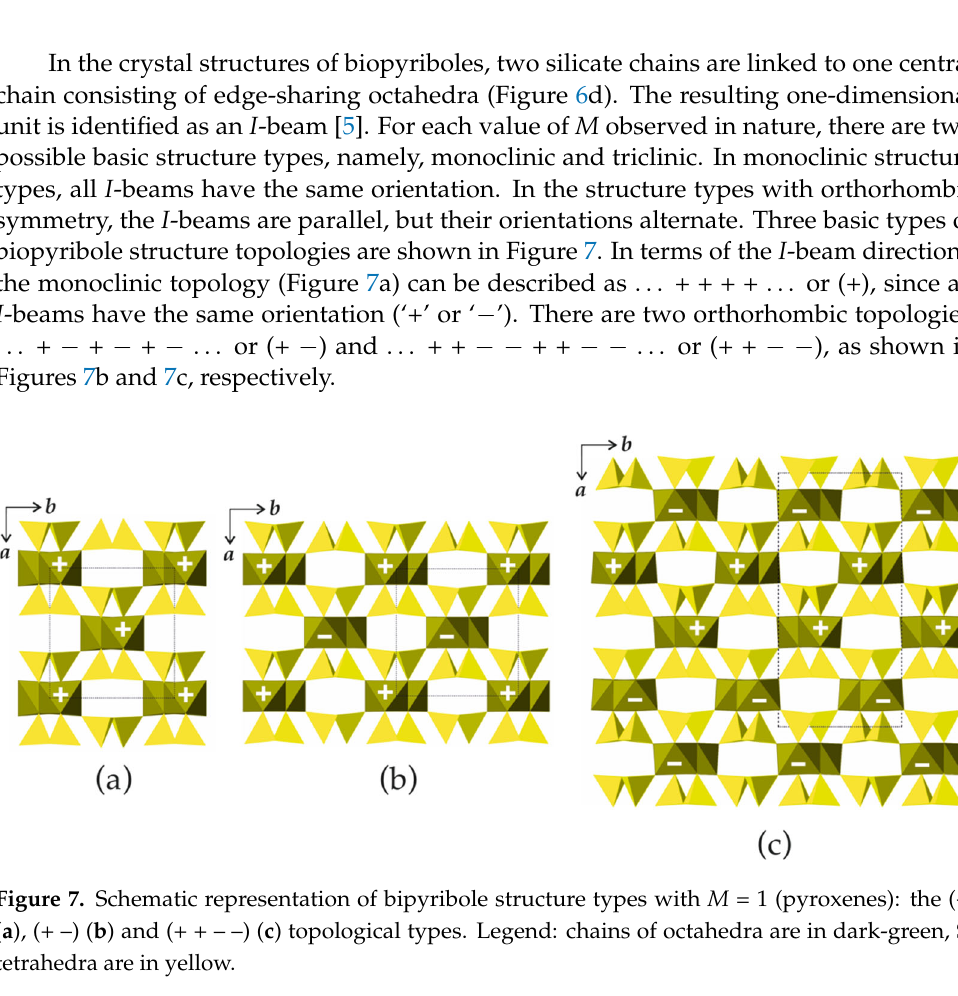
Table 2. Total structural complexities for basic biopyribole structure types.